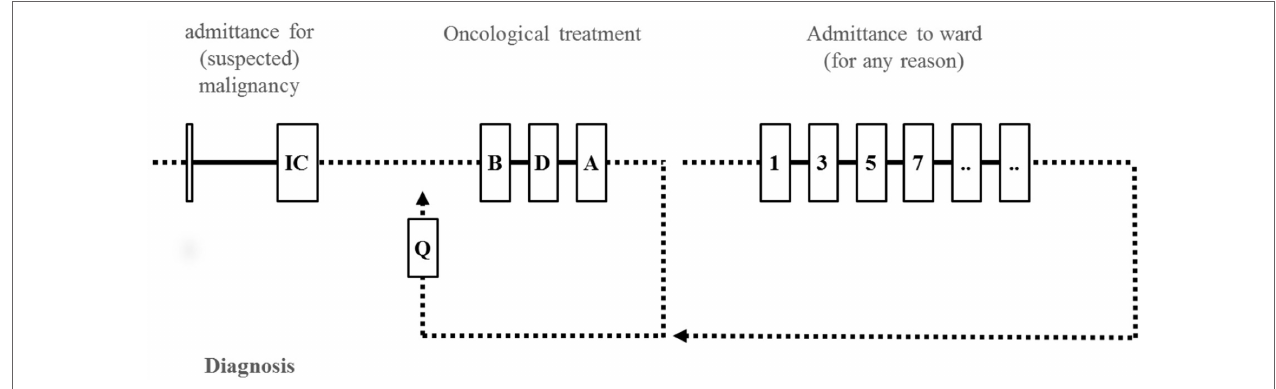
FigUre 1 | Design of the complement study . (When possible) blood was obtained during diagnosis ( T = IC). Further blood sampling of included patients took place during oncological treatment [before start ( T = B), during ( T = D), or after treatment ( T = A)] or during admittance for any other reason, such as, but not limited to (suspected) infection or episodes of febrile neutropenia (FN). Serial blood samples were drawn every other day ( T = 1, T = 3, T = 5, etc.) during admittance. After admittance for therapy or episodes of FN, patients were sampled when qualifying ( T = Q) for